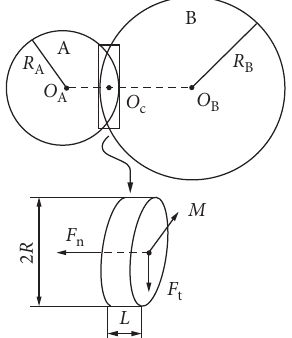
Figure 1: Hertz–Mindlin with bonding